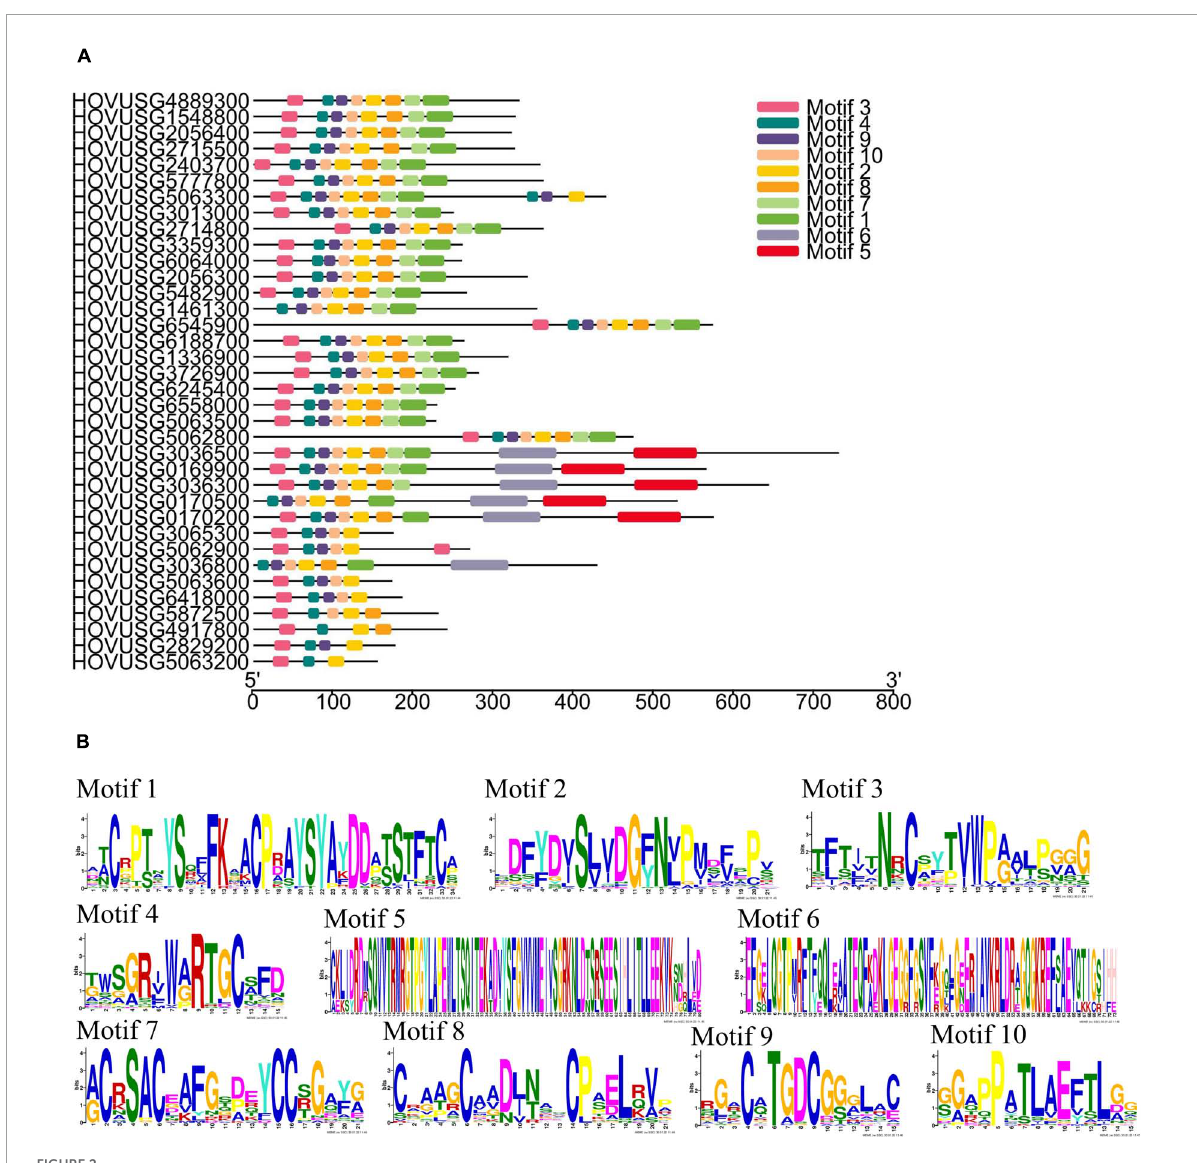
FIGURE2 Conserved motifs identified in the Qingke TLP proteins. (A) Distribution of conserved motifs. (B) Sequence logo of motifs identified. The height of a symbol reflects the relative frequency of the amino acid at that